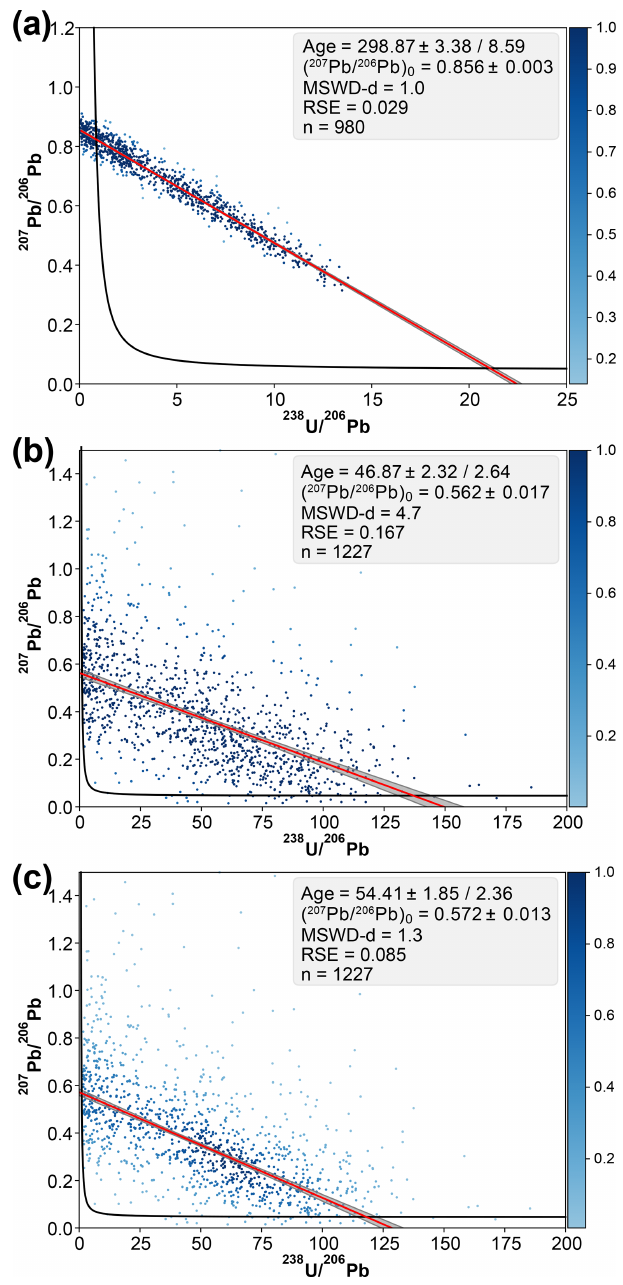
Figure 6. Results obtained for samples JS4 (a) and BM18 (b, c) . (a) TW concordia plot calculated by robust regression for sample JS4. (b, c) TW concordia plots calculated by robust regression for sample BM18. Pixels with 238 U / 206 Pb values higher than 200 are not shown ( n = 4). In panel (c) , the robust regression is weighted, with pixel weights calculated from a 2D kernel density estimate (see text for